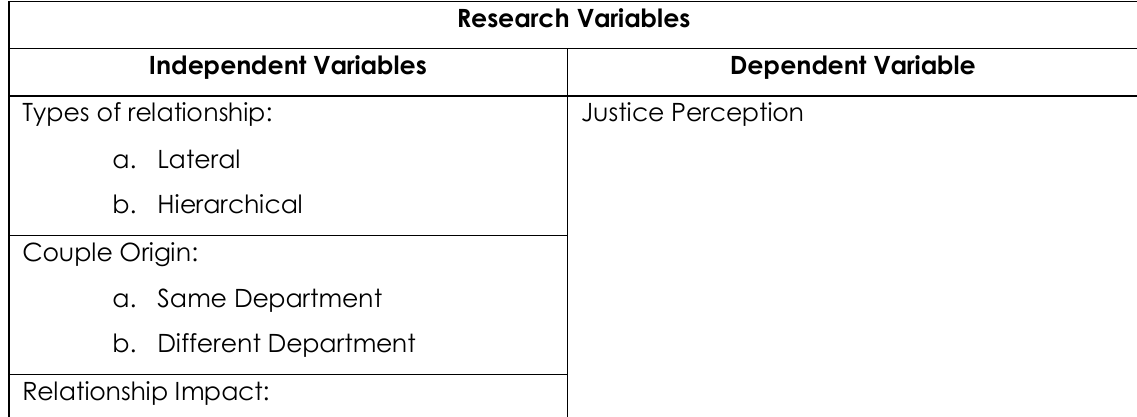
Table 1. Research